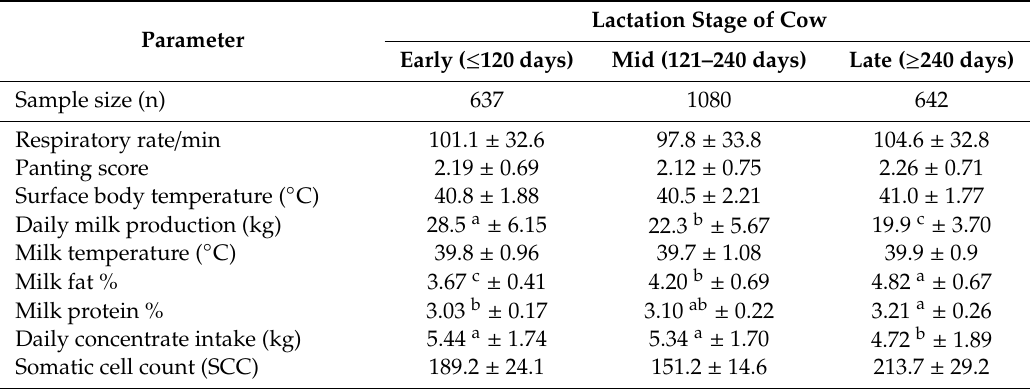
Table 3. E ff ect of lactation stage on physiological and milk parameters (Mean ± SD) of dairy cows exposed to THI from 70 to 84.